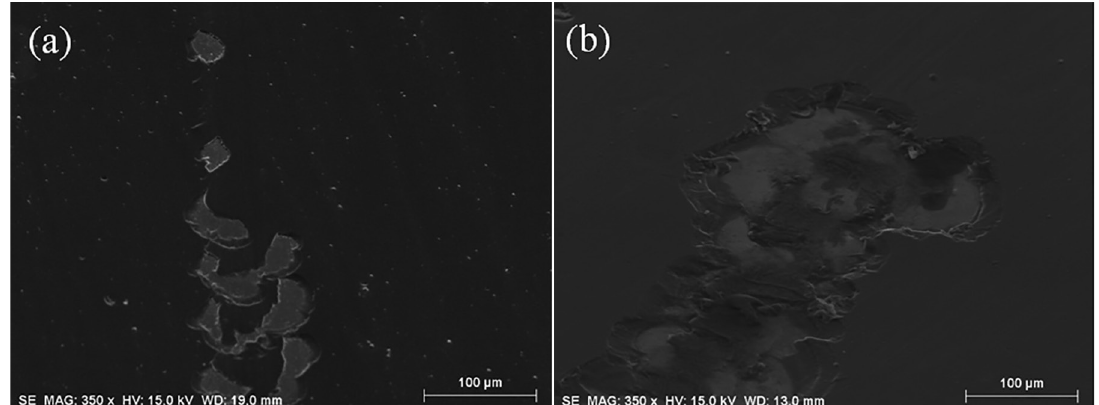
Figure 7: Scratch test tracks (a) Delamination region wedging (b) Final track point.